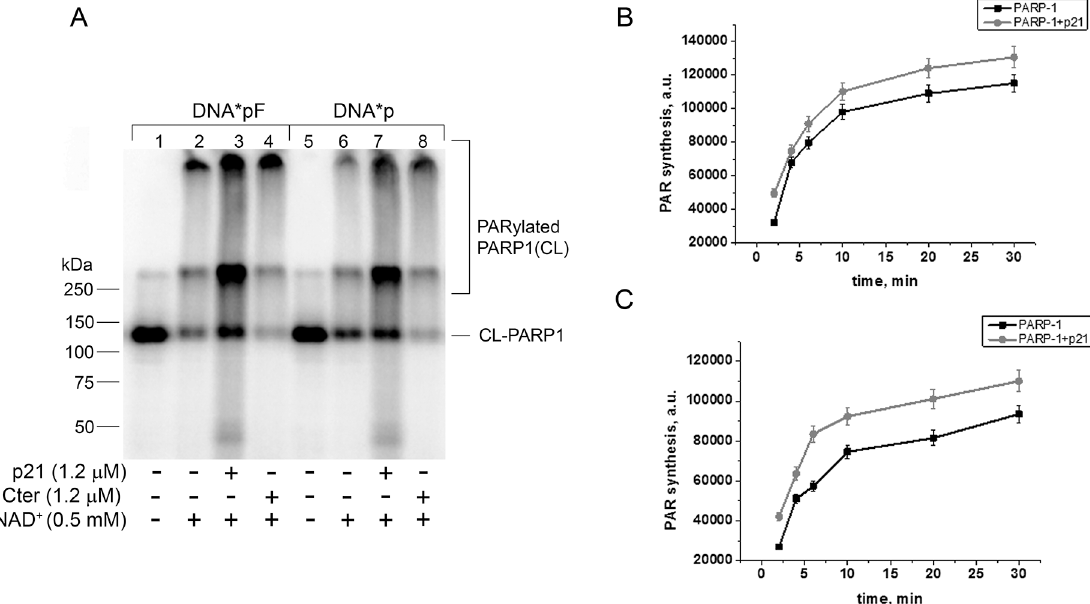
Fig 2. p21 stimulates the poly(ADP-ribosyl)ation activity of PARP-1 in the presence of nicked DNA. ( A ) Crosslinking assay of PARP1 activation in the presence (+) or absence ( − ) of p21. Photoreactive 5 ’ -[ 32 P]-labeled 0.1 μ M DNA * pF (lanes 1 – 4) or DNA * p (lanes 5 – 8) were incubated with 0.1 μ M PARP1 with (+) or without ( − ) NAD + . ( B,C ) Kinetic analysis of PARP-1 activity in the presence of p21. 0.2 μ M nicked DNApF (B), or DNAp (C) was incubated with 60 nM PARP-1, 100 μ M NAD + + 0.5 μ Ci [ 32 P]-NAD + in the presence of 1.2 μ M p21 (where indicated). The data are mean values ± S.D., n =